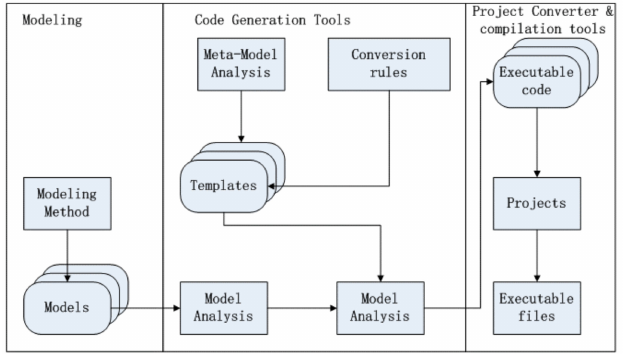
Figure 5. The steps of automatic code